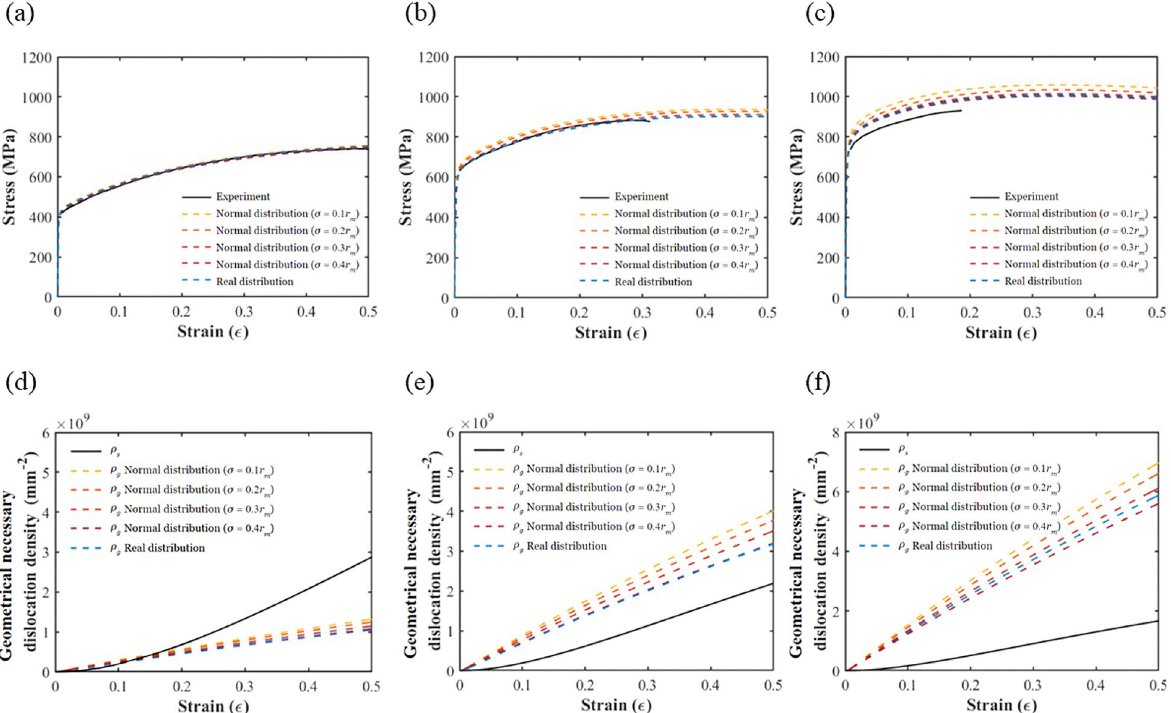
Figure 7. The stress–strain curves and dislocation density evolution curves for annealed samples with different precipitate size distributions: ( a ) stress–strain curves of 1273 K; ( b ) stress–strain curves of 1173 K; ( c ) stress– strain curves of 1073 K; ( d ) dislocation density curves of 1273 K; ( e ) dislocation density curves of 1173 K; and ( f ) dislocation density curves of 1073